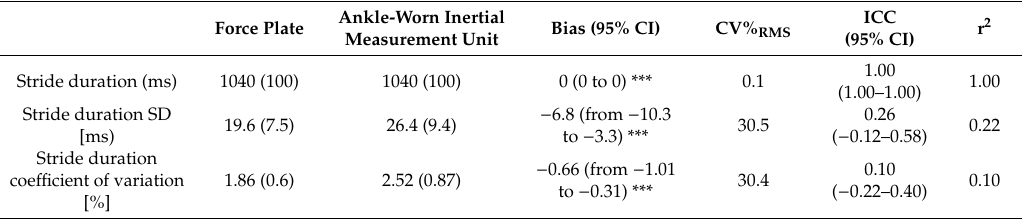
Table 2. Concurrent validity of the stride characteristics measured with a force plate and an ankle-worn inertial measurement unit (session